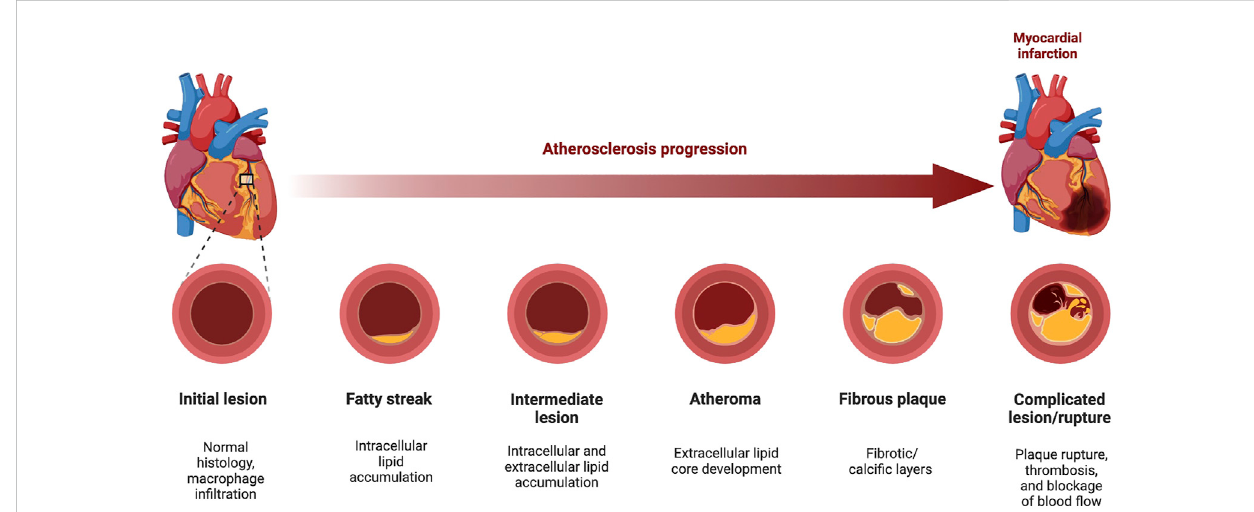
FIGURE 1 Progression of Atherosclerosis. The development of atherosclerosis is a 5-step process from the initial development of the fatty streak into an atherosclerotic lesion, through to the development/rupturing of fi brofatty atheroma. During atheroma development, patients develop hypertension as thearterybecomesnarrowedorcompletelyblocked,forcingthehearttopumphardertopassbloodthrough.Elasticityofthevasculartissueallowssome fl exibility as the lumen narrows, and the mediators of this elasticity also promote the formation of the fi brotic cap on the plaque, providing stability. However,thesubsequentrupturingofthisplaquecanleadtoamyocardialinfarctionbyblockingcardiacbloodsupplyormayevencauseplaquedebristo traveltobloodvessels,reachingdistantorgans(i.e.,brain,kidneys,heart)andcausinganinfarction(heartorkidneys),orastroke(brain).Inthisdiagram,an example of coronary atherosclerosis development is depicted. Atherosclerosis can also form in the aortic arch, as well as in carotid and femoral arteries (Figure made with